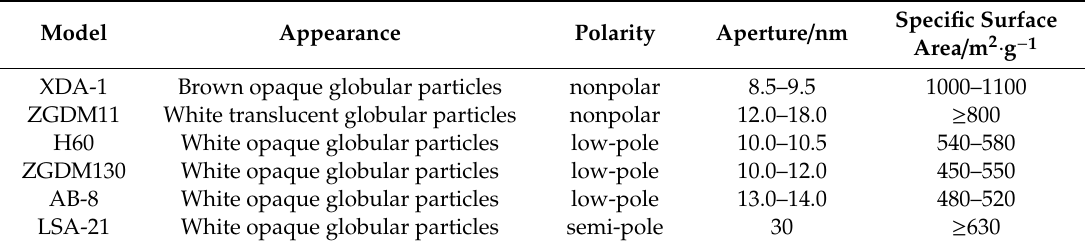
Table 1. Physical properties of the six kinds of macroporous